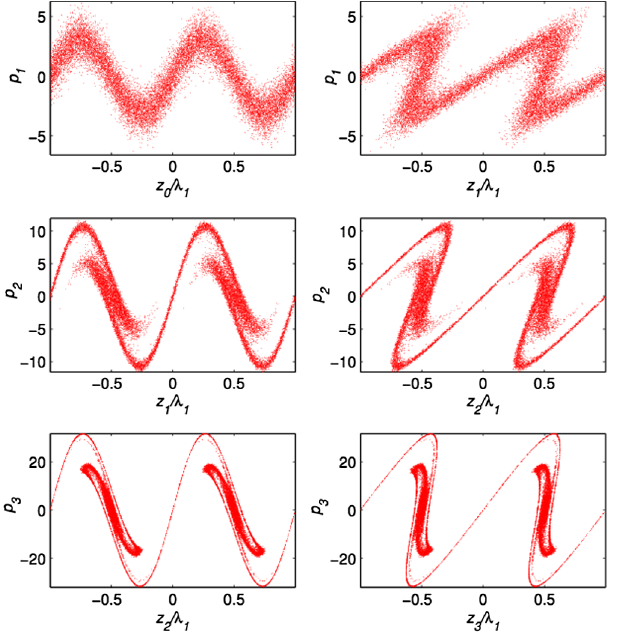
FIG. 12. Adiabatic buncher with three modulations of wave- length (cid:6) 1 . Here A 1 ¼ 3 , A 2 ¼ 3 A 1 , A 3 ¼ 3 A 2 , B 1 ¼ 1 : 8 =A 1 , B 2 ¼ 2 : 2 =A 2 , B 3 ¼ 1 : 55 =A 3 , (cid:3) 2 ¼ (cid:3) 3 ¼ 0